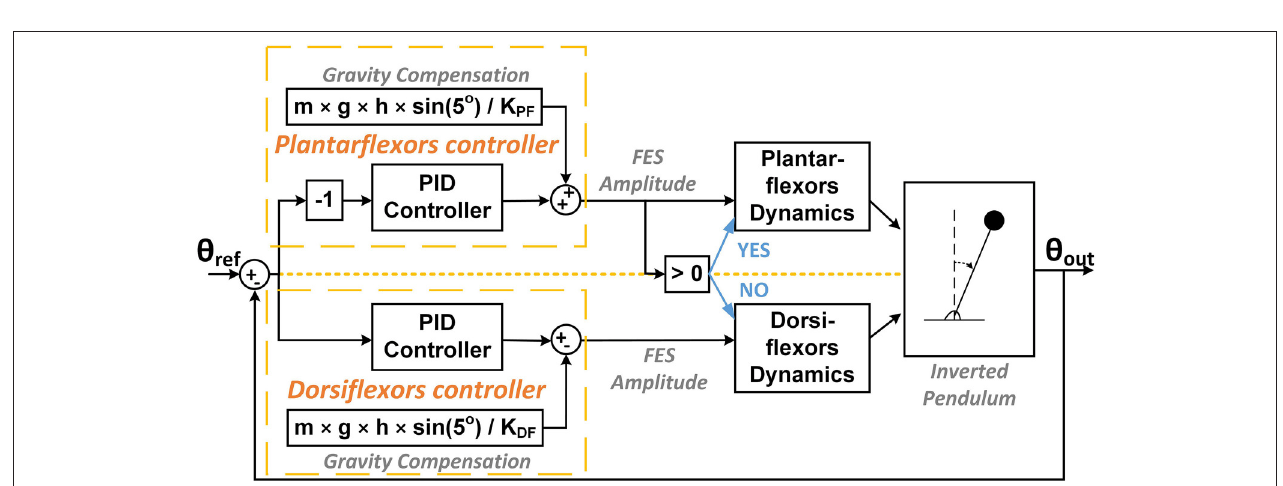
FIGURE 2 | Block diagram depicting the PID plus gravity control